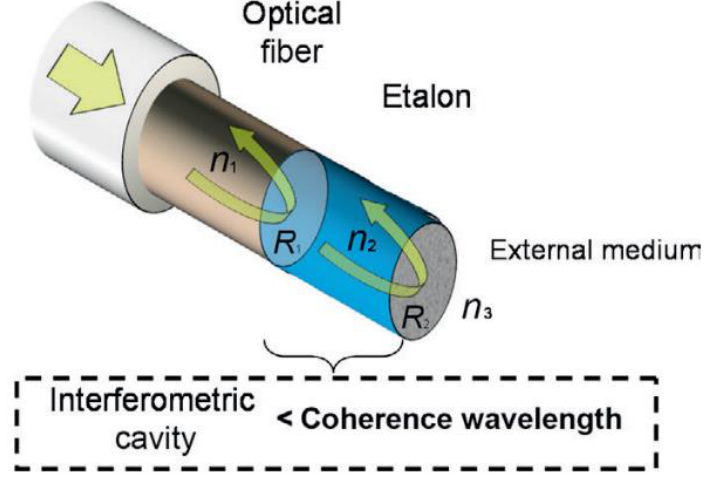
Figure 17. Optical fibre interferometer. (Reprinted with permission from ref. [63]. Copyright 2014 Elsevier).